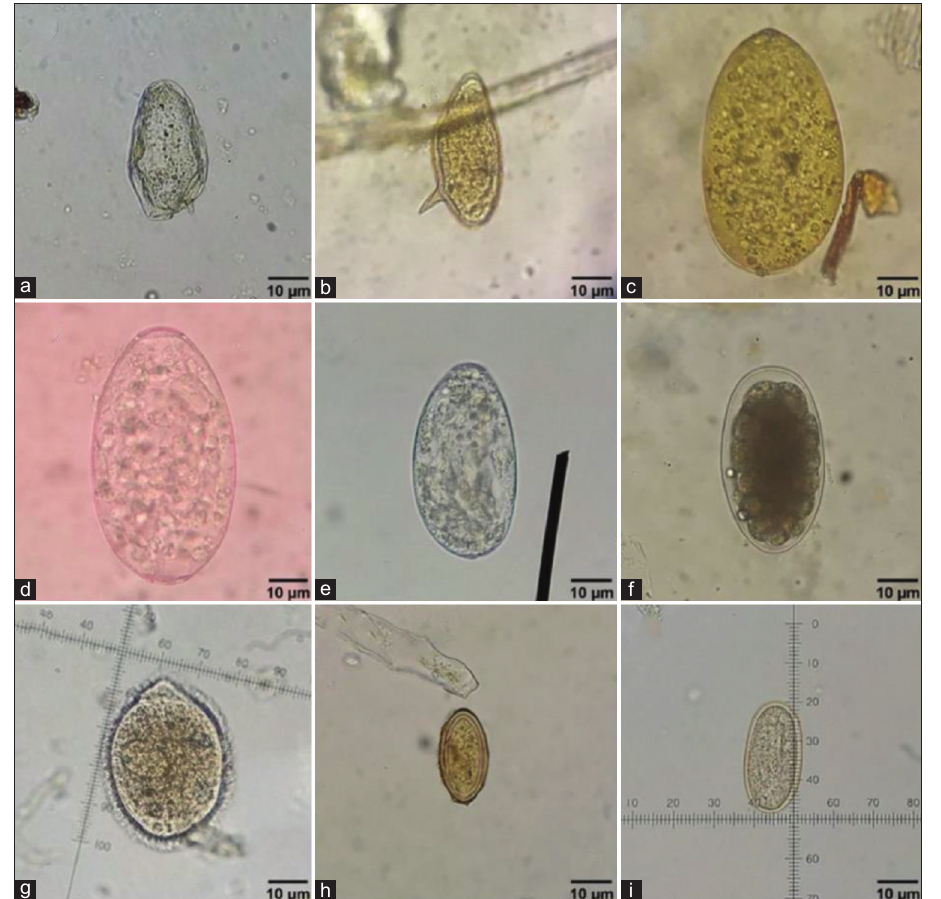
Figure-2: Parasite ova identified from water buffalo feces using formalin-ethyl acetate sedimentation technique. (a) S. japonicum . (b) Schistosoma spp. with long spine (in cow). (c) Fasciola spp. (d) Paramphistome spp. (e) Amphistome spp. (f) Strongyle spp. (g) Balantidium spp. (h) Eurytrema spp. (i) Gongylonema pulchrum (scale bar = 10 µ